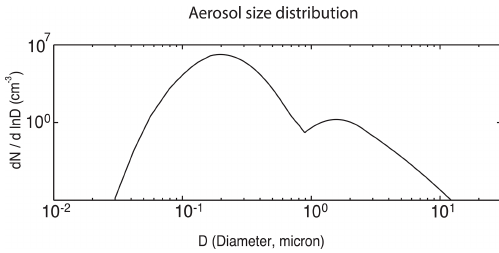
Figure 4. Time series of PM 2 . 5 observed at the station in the Yellow Sea (blue line) and of the average PM 2 . 5 over stations in the simulation domain (red line) between 03:00 and 18:00LST on 13 April 2016.